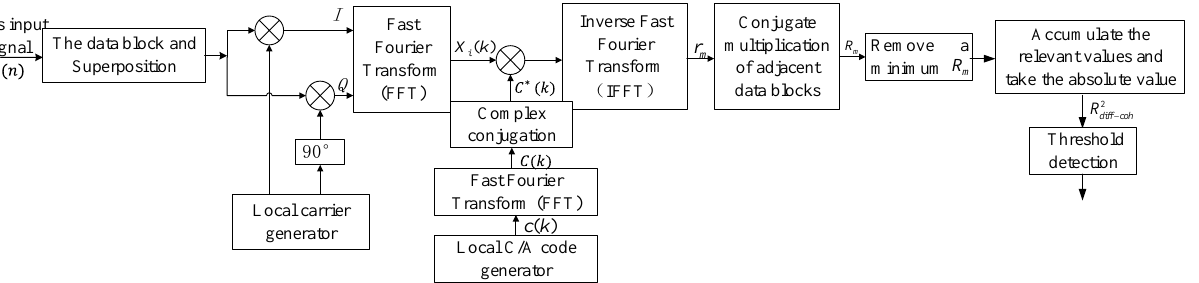
Figure 6. Schematic diagram of the acquisition algorithm based on differential coherent integration combining coherent accumulation and bit sign transition estimation.